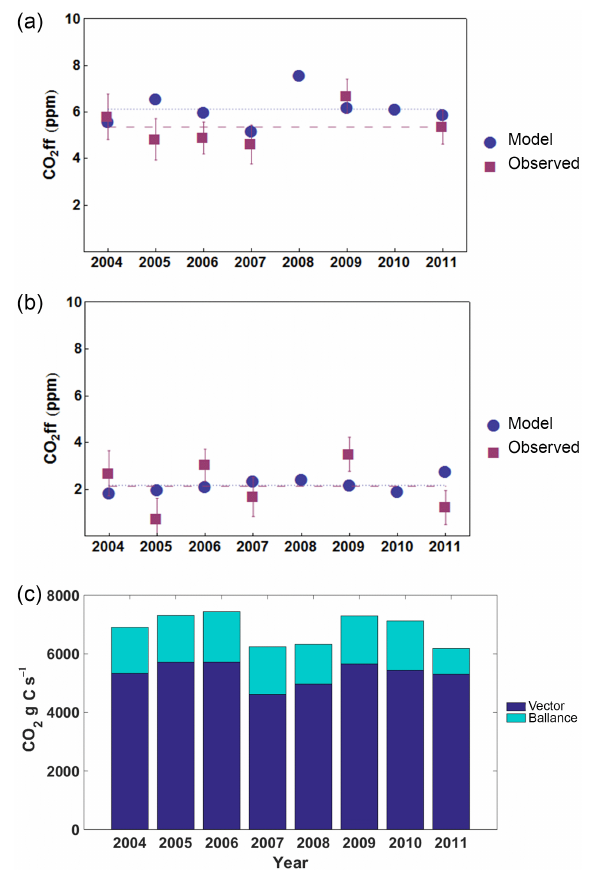
Figure 4. Pine tree (a) and chestnut tree (b) modelled CO 2 ff tree vs. observed CO 2 ff in each year between 2004 and 2011. Dotted and dashed lines show modelled and observed 6-year means respec- tively (2008 and 2010 are excluded due to lack of observations). Bottom panel (c) shows the average emissions rate in gCs − 1 for Vector and Ballance in each year for